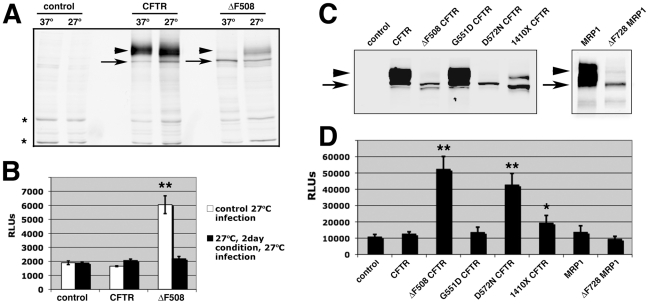
Effect of low temperature conditioning or expression of other misfolded proteins on AAV2 infection.A. Western blot showing immature form of CFTR and ΔF508 (black arrow) and mature glycosylated form (arrowhead). Following low temperature conditioning (2 d, 27°C), a significant amount of ΔF508-CFTR becomes more complexly glycosylated. Asterisks (*) represent non-specific banding and demonstrate equal loading. B. Luciferase assay of transduction after low temp conditioning, and a comparative control at 27°C. Cells were infected with AAV2 (10,000 vg/cell) as indicated and luciferase activity was measured 24 hr later. C. Comparative analysis of mutant CFTR processing with AAV2 transduction. Western blot of proteins expressed in BHK-21 cell lines depicting level of glycosylation of CFTR, and mutants ΔF508 (misfolded), G551D (properly folded), D572N (misfolded), 1410× (intermediate folding defect). Related ABC transporter proteins MRP1 and an analogous mutant ΔF728-MRP1 are also shown. D. Luciferase assay for transduction in these cell lines following administration of AAV2 (10,000 vg/cell). Samples that were statistically different from controls are indicated with p-values marked (*p<0.05; **p<0.01).